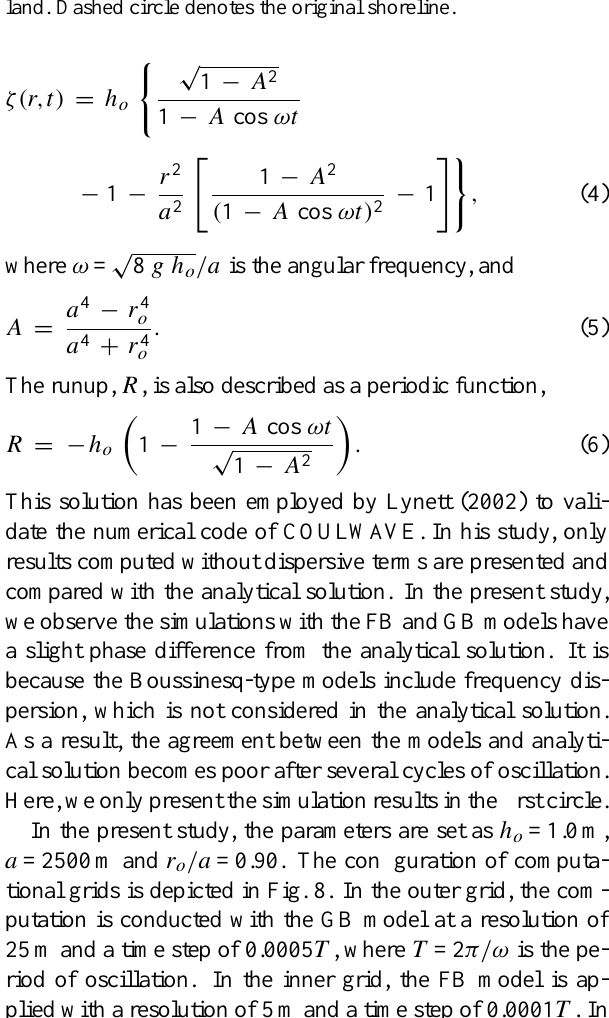
Fig. 10. Numerical wave tank for the experiments with conical is- land. Dashed circle denotes the original shoreline.